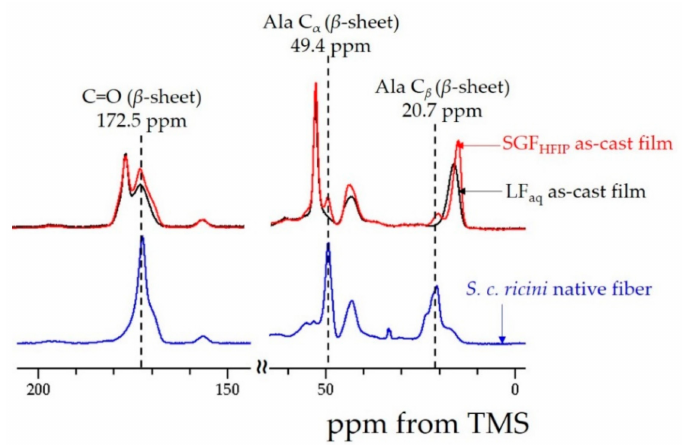
Figure 3. 13 C solid-state NMR spectra in the ranges 0 to 55 and 150 to 200 ppm of S. c. ricini native fiber (spectrum in blue), and LF aq (spectrum in black) and SGF HFIP (spectrum in red) as-cast